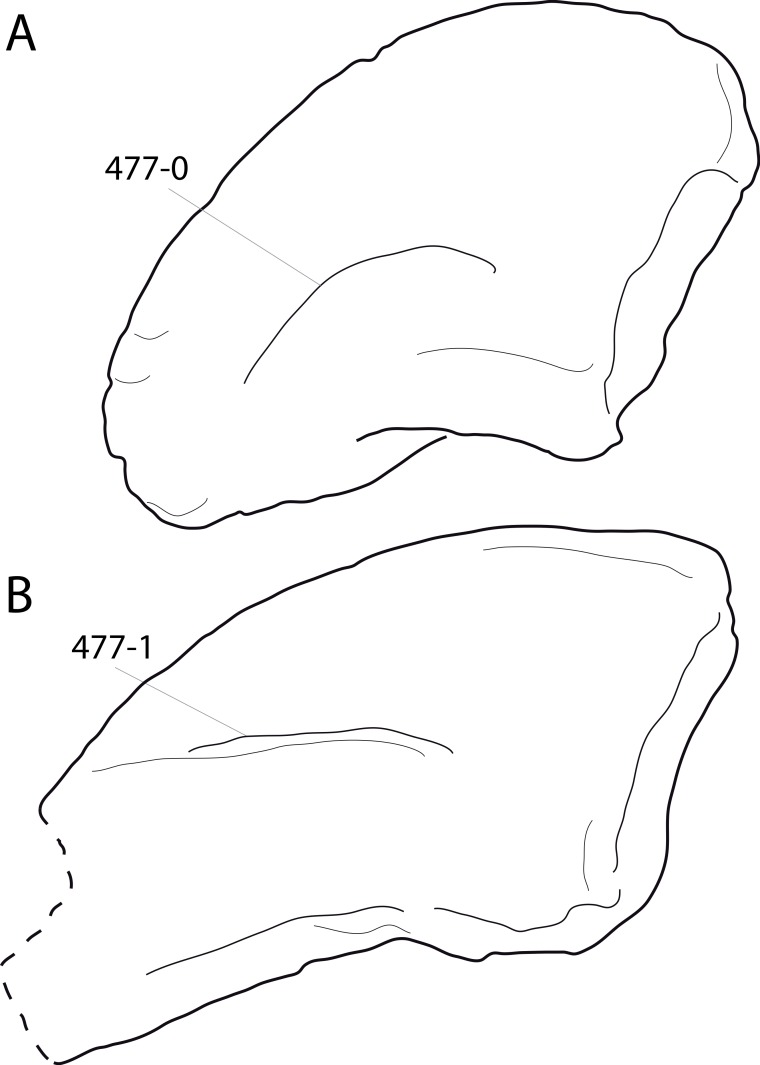
Eusauropod pedal ungual I.Pedal ungual I of Cetiosauriscus stewarti NHMUK R3078 (A) and Dyslocosaurus polyonychius AC 663 (B) in lateral view, illustrating the two different courses of the canals (curved, A, C477-0; straight, B, C477-1). Dotted lines indicates the broken tip. Scaled to same proximal articular surface height.